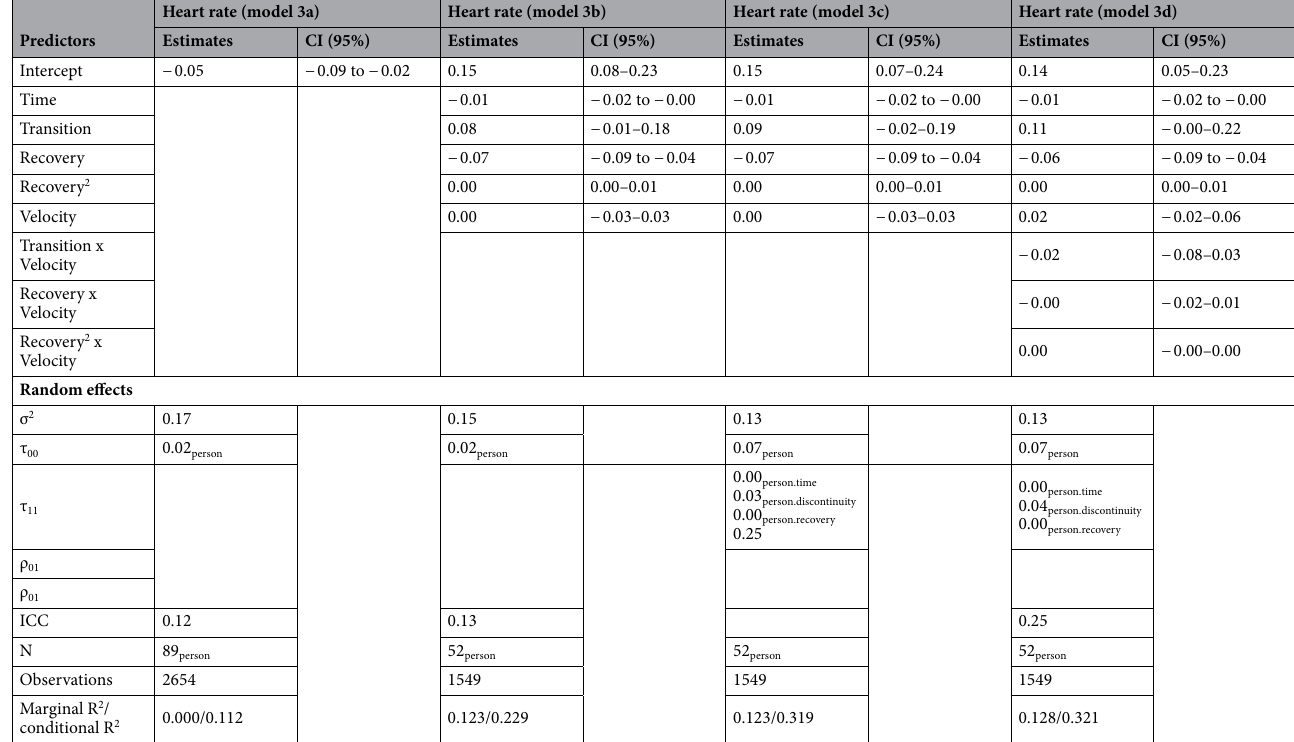
Table 4. Parameter estimates for discontinuous random coefficient models used to estimate effect of resolution velocity on